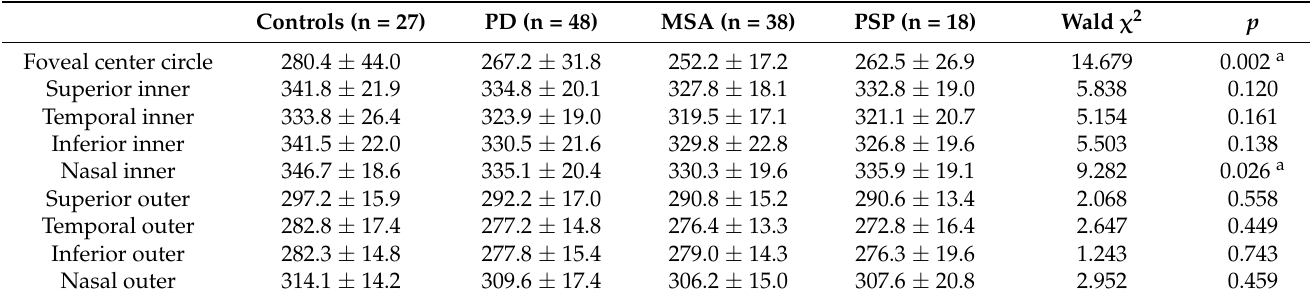
Table 5. Macular thickness ( µ m) of patients with PD, MSA, PSP, and controls.